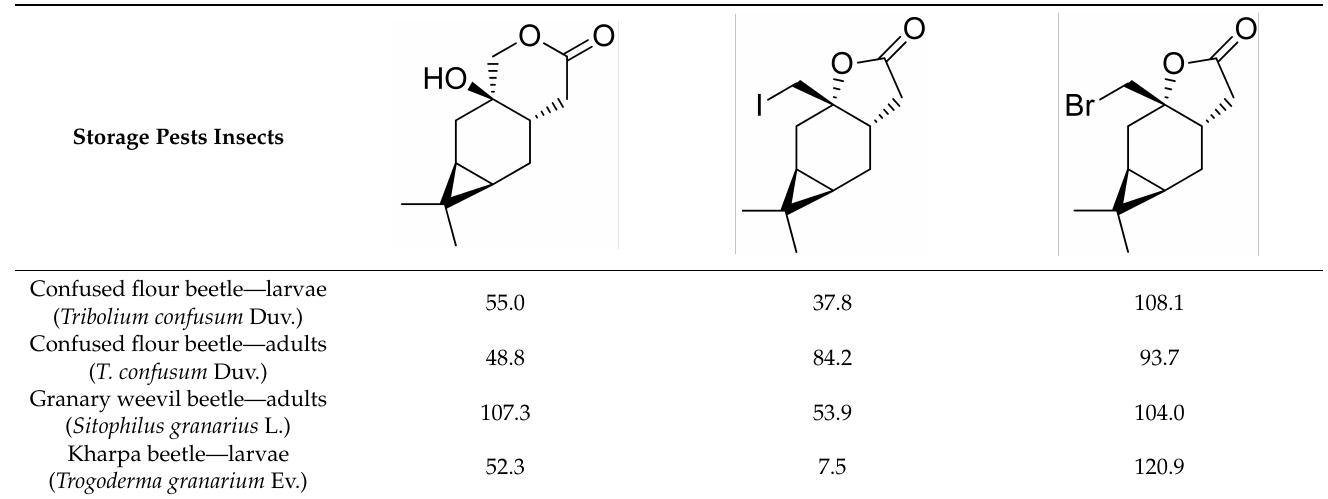
Table 1. Feeding deterrent activity of lactones with carane